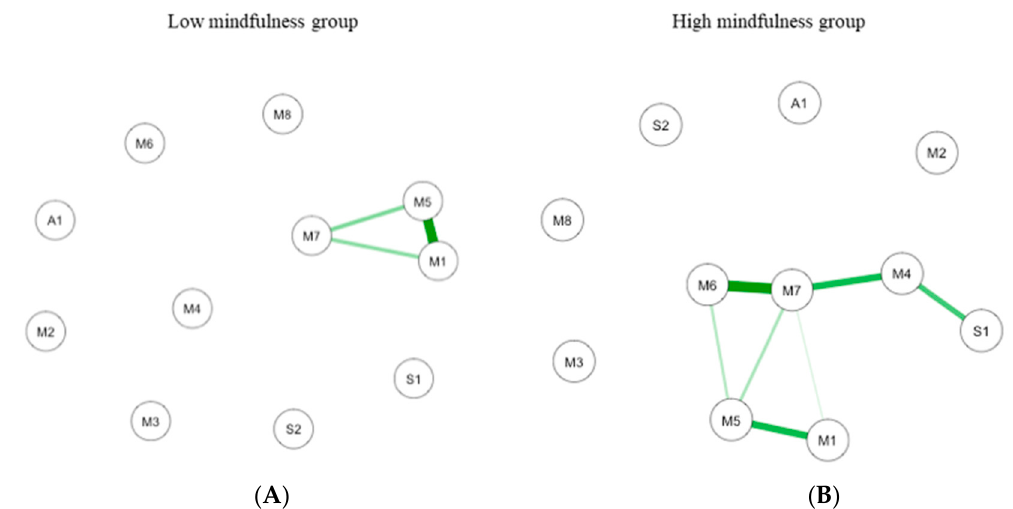
Figure 7. GLASSO-regularized partial Pearson correlation networks of interoception subscales, mindfulness subscales, and subjective olfactory acuity, resulting from low mindfulness ( A ) and high mindfulness groups ( B ). S1 SPANE positive emotion; S2: SPANE negative emotion; F1: FMI presence;